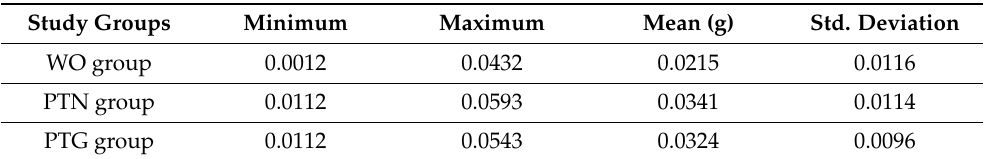
Table 2. Minimum, maximum and mean values of apically extruded debris weight (g) among the study